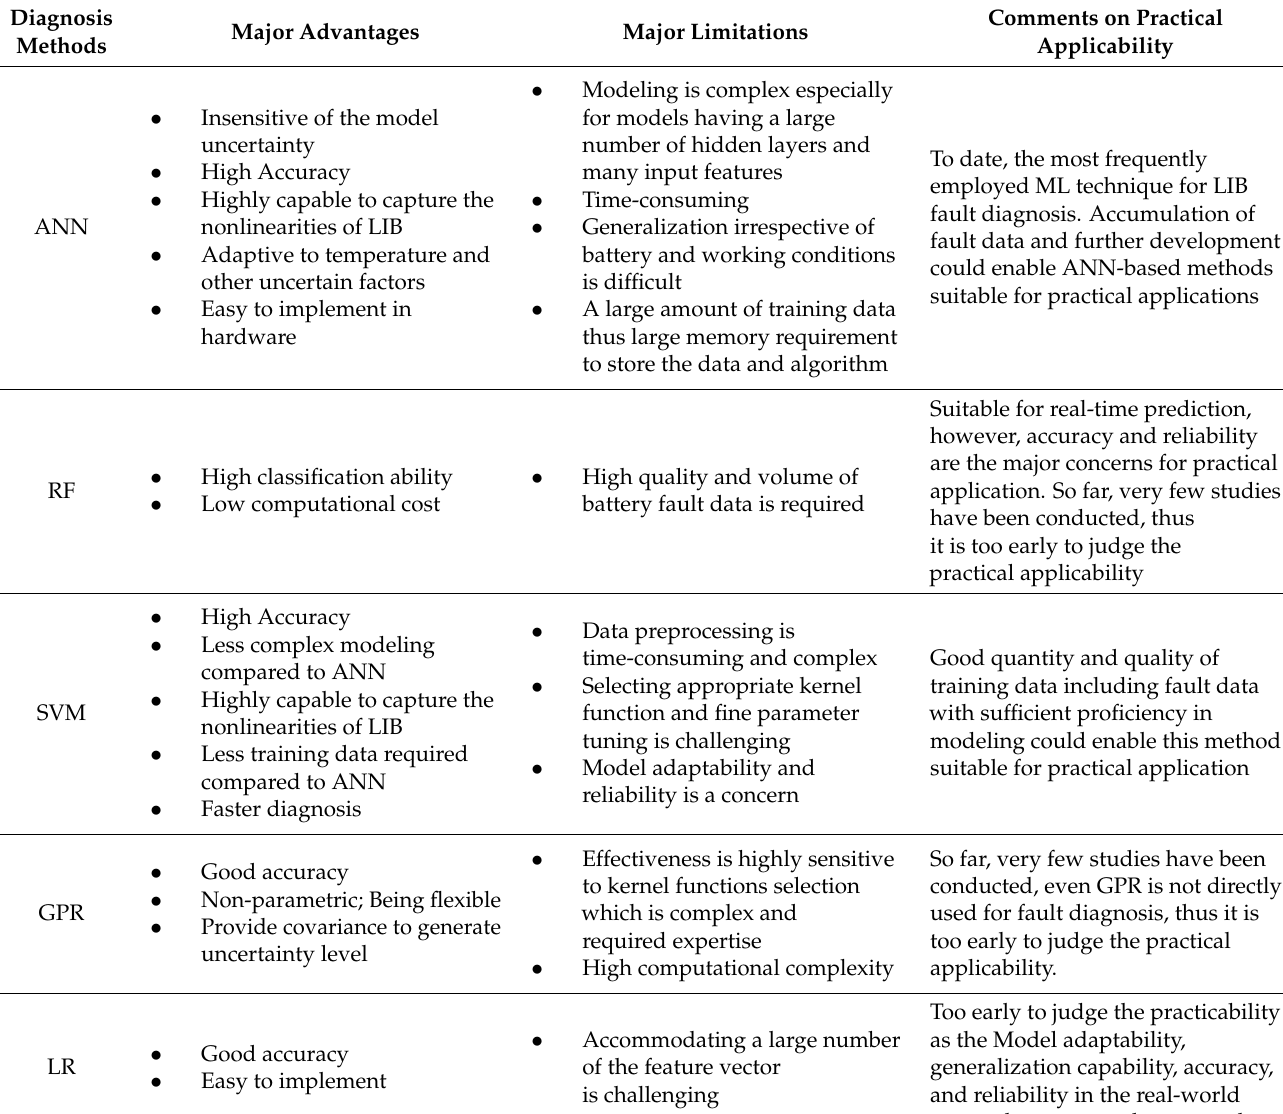
Table 1. Comparative analysis among ML-based LIB fault diagnosis